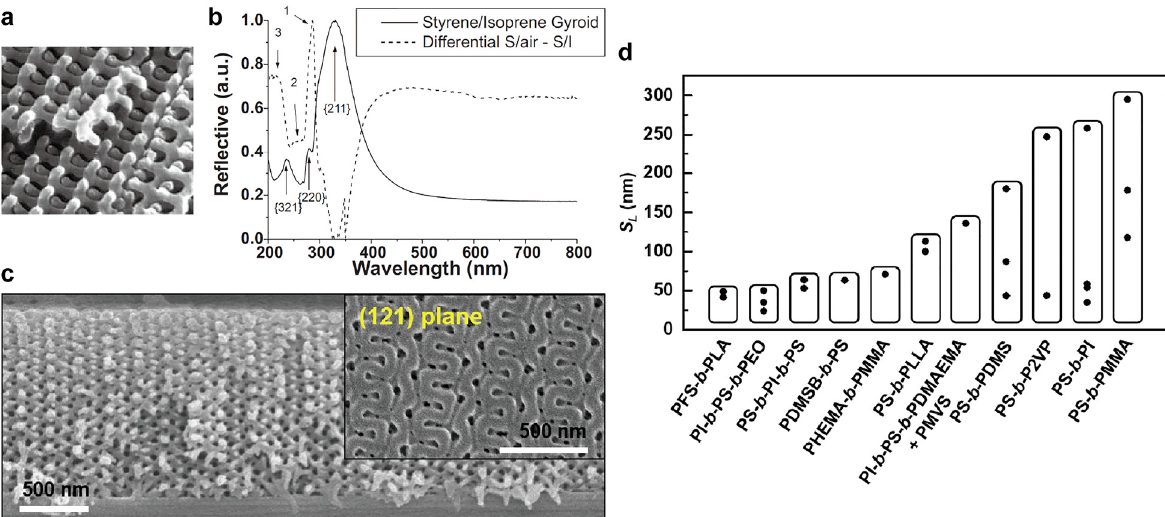
Figure 8: Gyroid structures obtained from solvent-assisted processes for HMW BCPs and lateral unit-cell size ( S L ) of various BCP gyroids. (a) SEM image of PS gyroid structure (as fracture surface), which was obtained from UV-etched PS- b -PI (300 – 450 kDa). S L was estimated as ̅̅ √ × 2 π / q fl ectance spectraof PS- b -PI (solidcurve) and PS(dottedcurve) gyroidstructures.For PS- b -PI fi lm,optical 258 nm by S L = 2 { 220 } . (b) Re re fl ectancepeaksat λ =324,281,and212nmcorrelatewith{211},{220},and{321}planesofgyroidstructures,respectively.(c)Cross-sectional SEM image of giant ( S L = 295 nm) gyroid structure and top-view image, which was obtained from 600-kDa PS- b -PMMA. (d) Representative gyroid S L values reported to date. Reproduced with permission from ref. [11]. Copyright 2002, Wiley-VCH Verlag GmbH Weinheim (a) and (b); reproduced with permission from ref. [50]. Copyright 2016, Nature Portfolio